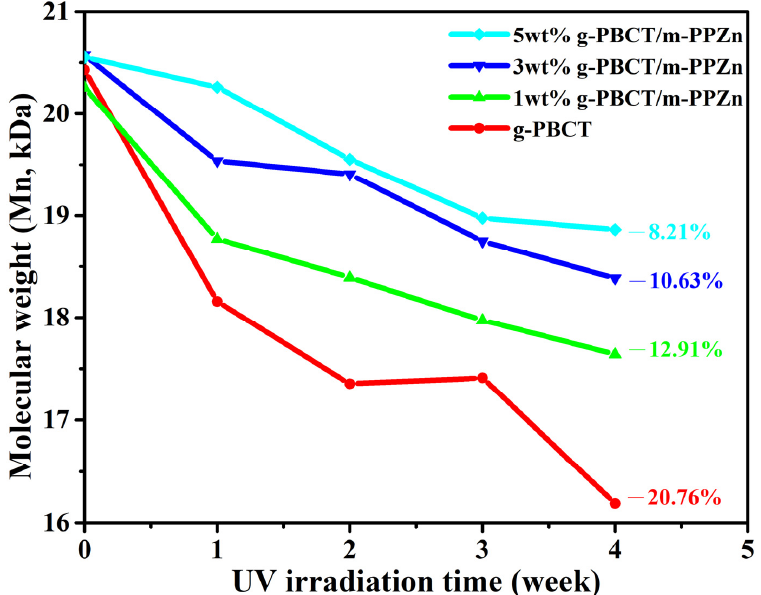
Table 2. Number-average molecular weights (Mn) of g-PBCT/m-PPZn composites after 4 weeks UV irradiation.